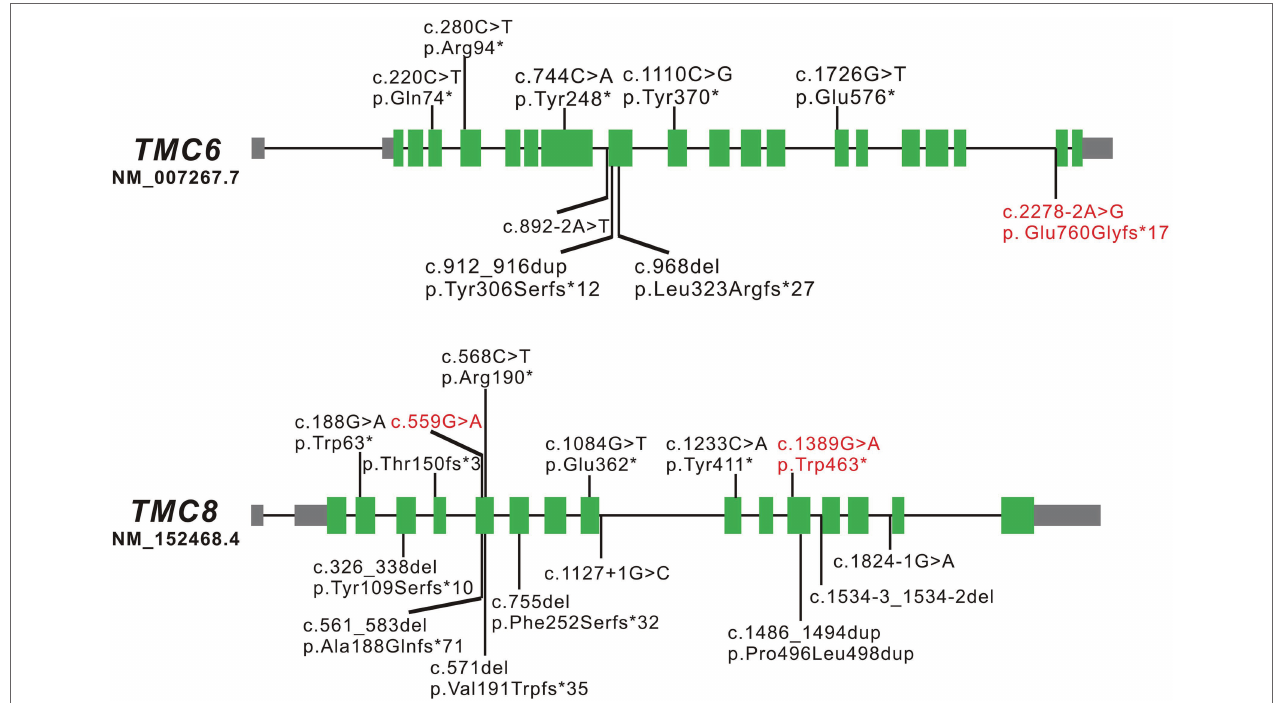
FIGURE 3 | Schematic diagrams of TMC6 and TMC8 . The green boxed regions denote exons, gray boxed regions represent 5 ' - or 3 ' -untranslated regions, and connecting solid lines indicate introns. The variants marked in red are the novel variants detected in the present study; those marked in black are the variants reported to